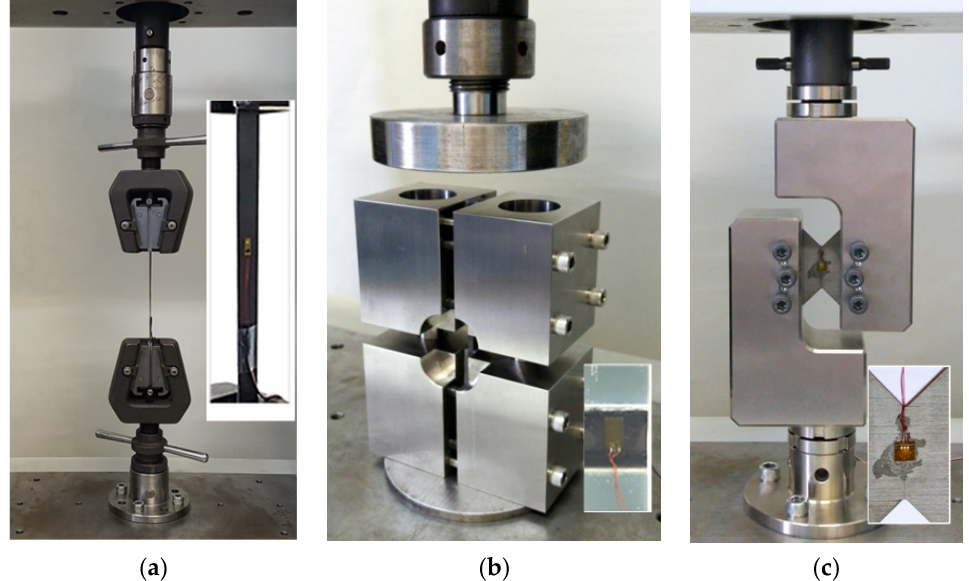
Figure 2. Experimental set-up for the various modes of loading and SG location; ( a ) tension; ( b ) compression; ( c ) shear.